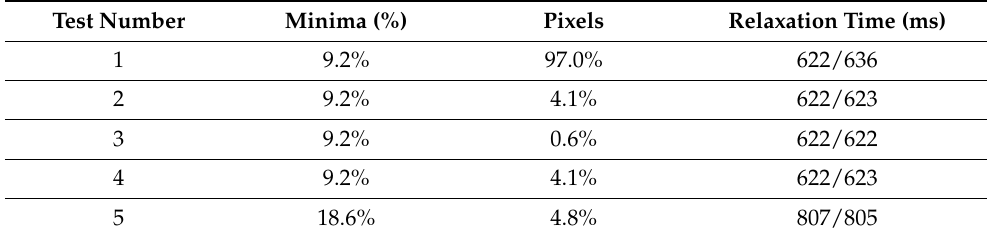
Figure 2. Bland-Altman plot corresponding to Test 8 (inversion recovery, simulated human data). T1 values show a significant dispersion. Moreover, T1 obtained by Matlab’s fit (Lebenberg-Marquardt) is greater than the one attained by RD-NLS. Table 3. Results from the tests. Notice that the T2 fits (Tests 11–14) are much more similar for the compared algorithms than the T1 fits (Tests 1–10). Also, the T2 fits (Tests 11–14) show no multiple minima, whereas multiple minima are common in the T1 fits (Tests